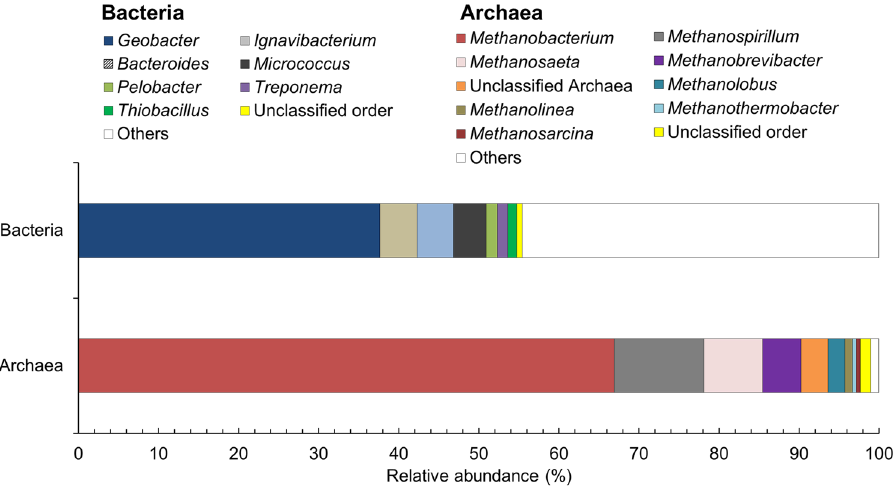
Figure 2. Community composition of bacteria (top) and archaea (bottom) using Best Hit Classification based on the SILVA Small Subunit (SSU) rRNA database in MG-RAST. The total abundance of SSU rRNA gene reads was 27,084: 22,946 reads were bacterial, and 982 reads were archaeal. The category “Others” indicates these genera of archaea and bacteria had relative abundance below 1%.